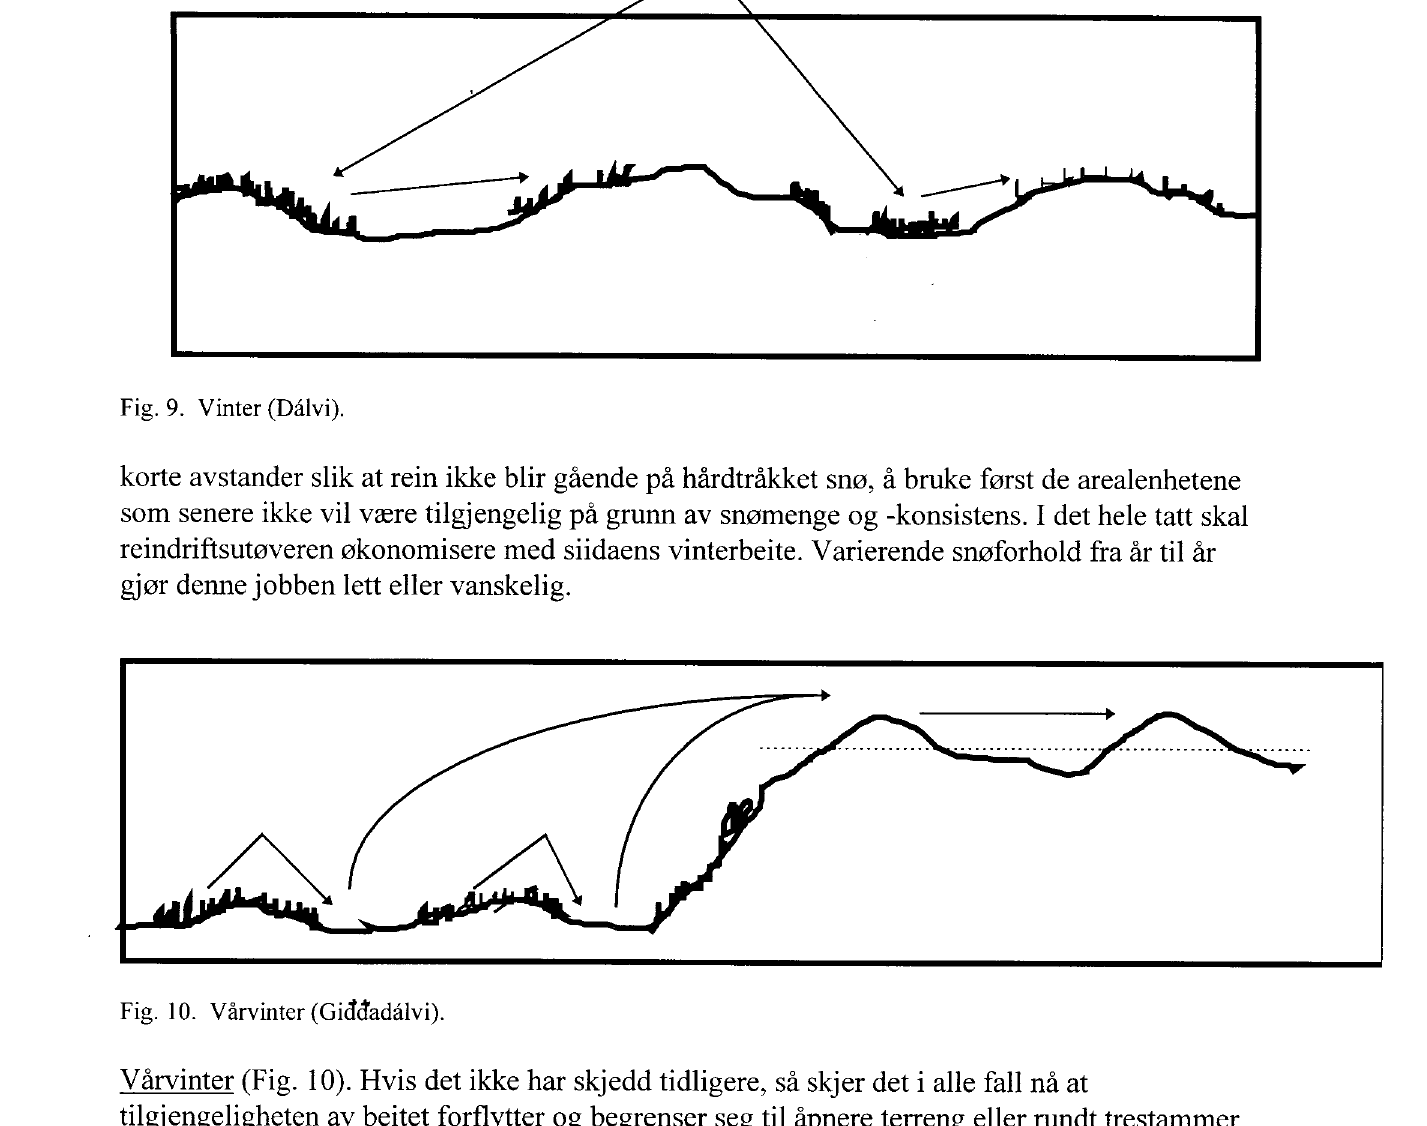
Fig. 10. Vårvinter